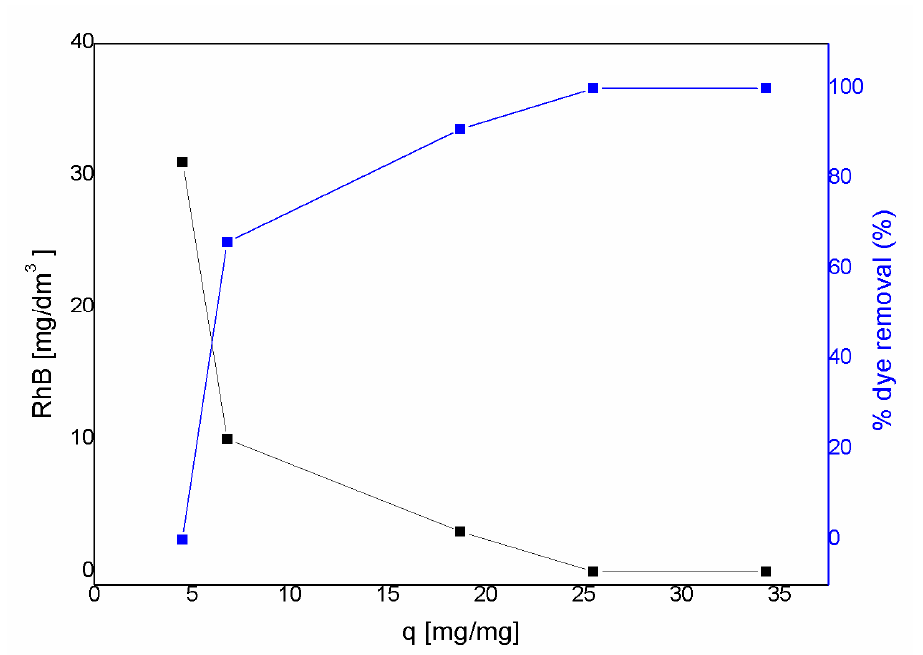
Figure 6. Effect of the activated carbon dosage (chemical activation 1:2, straw pellet sample) in the range 2.7–20.6 mg AC for 30 mg/dm 3 of Rhodamine B solution, sorption at 25 °C determined by UV-VIS analysis, where: q—the activated carbon per mass of the dye adsorbed, AC/RhB. % dye removal—percentage of RhB dye adsorbed by the activated carbon (with unchanging initial concentration of dye). Table 3. The adsorption parameters.